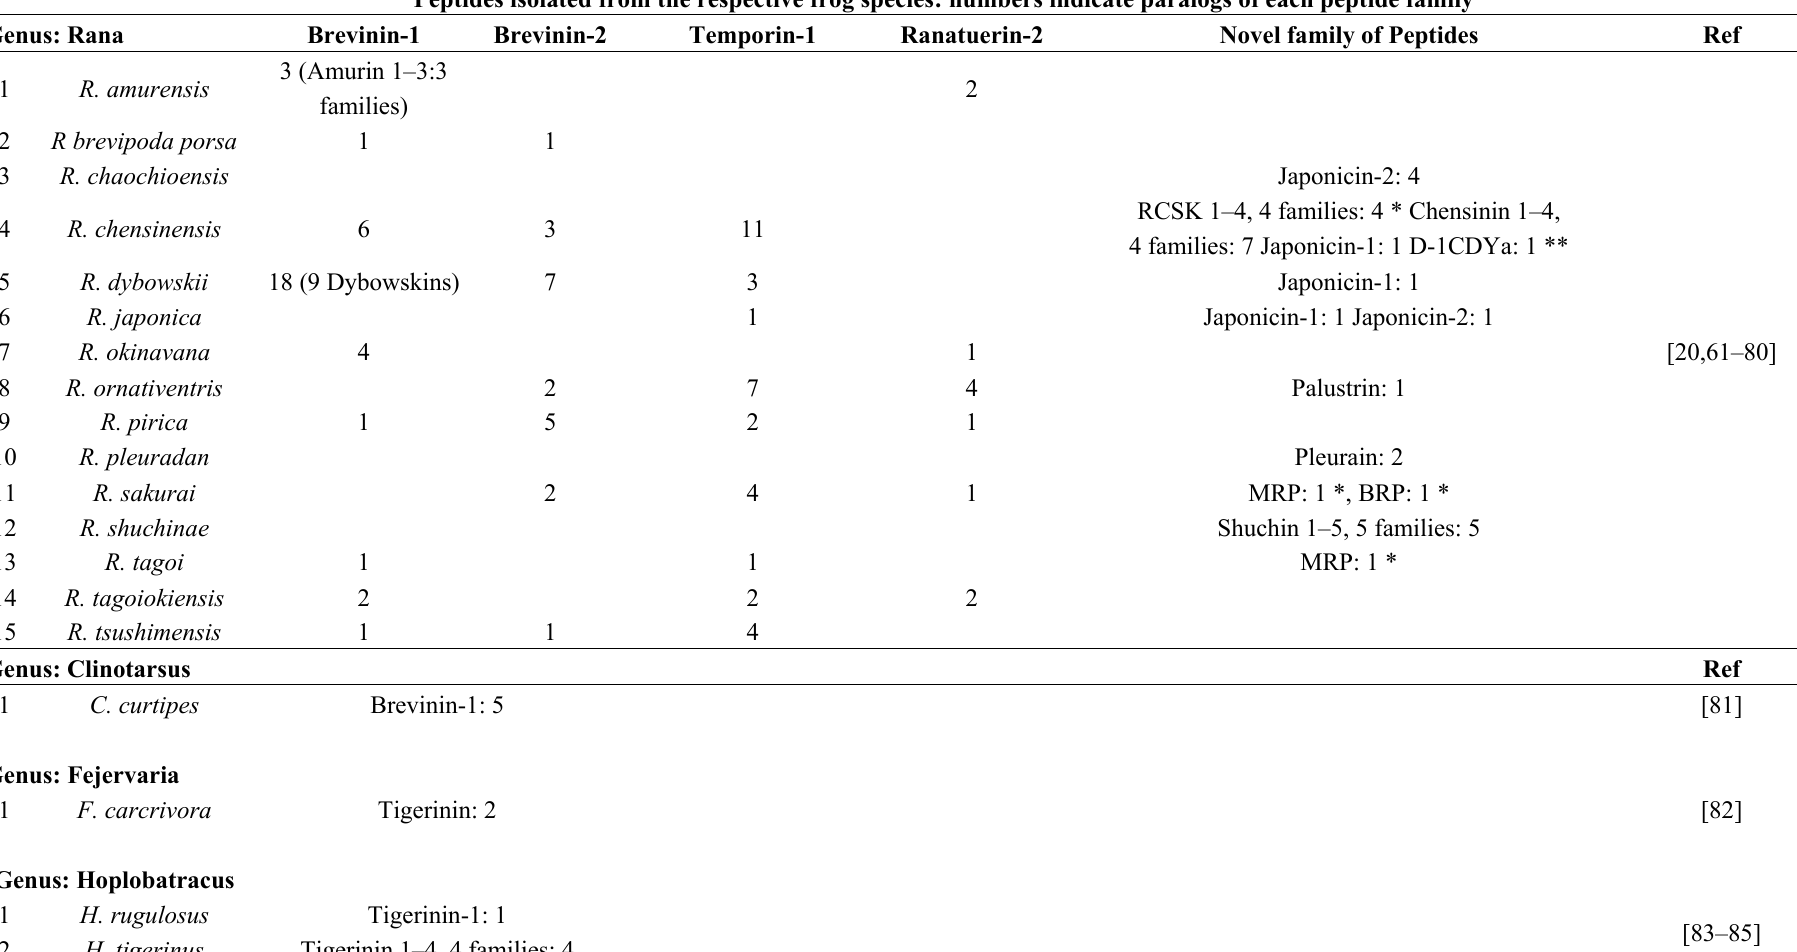
Table 1. Cont . Peptides isolated from the respective frog species: numbers indicate paralogs of each peptide